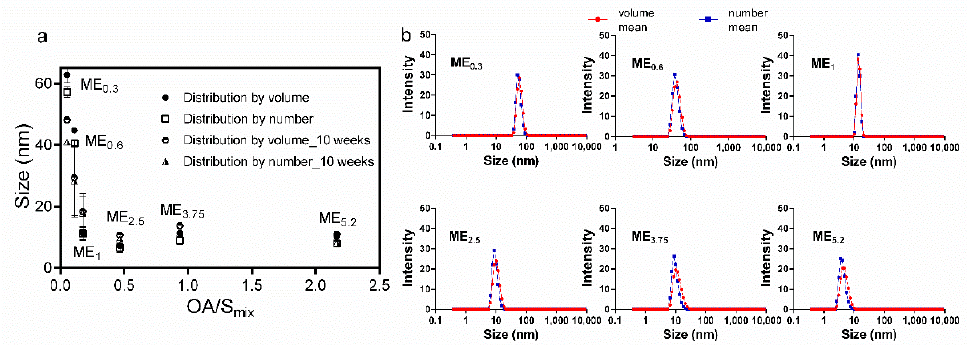
Figure 2. DLS characterization of MEs. ( a ) Effect of OA: S mix on the size of the selected MEs immediately after preparation and 10 weeks later. Data are presented as distribution by volume and number as the means ± SD, n = 3. ( b ) Size distributions profiles.